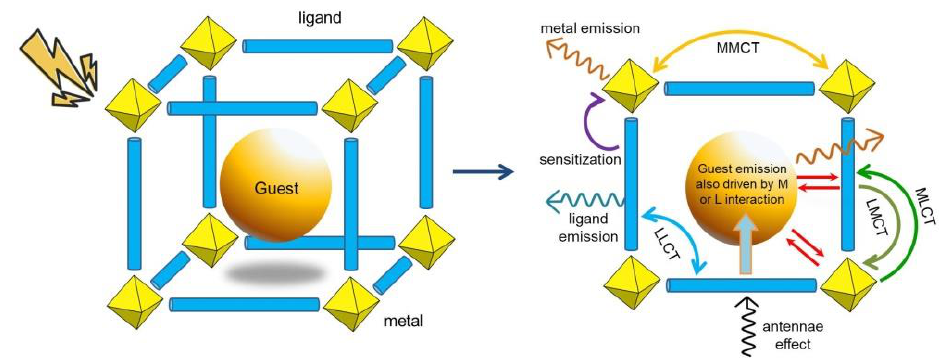
Figure 4. MOF-luminescence-based mechanisms of signal transduction.